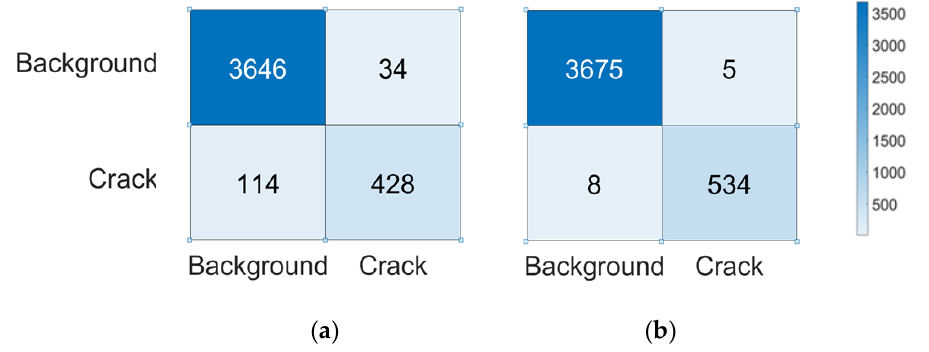
Figure 17. Confusion matrix constructed based on the recognition results using ( a ) the original CPD and ( b ) the MLP–CNN.